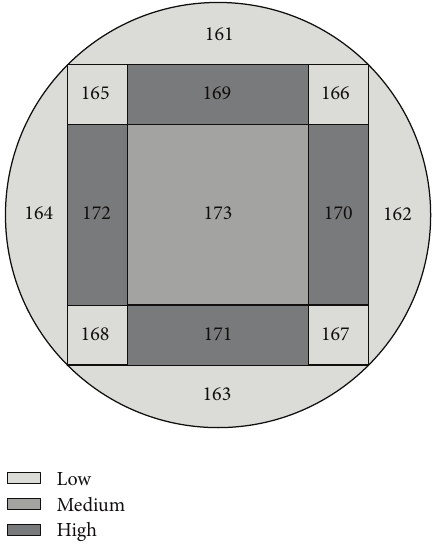
Figure 19: UPC LSTF pseudo-3D nodalization core channels.